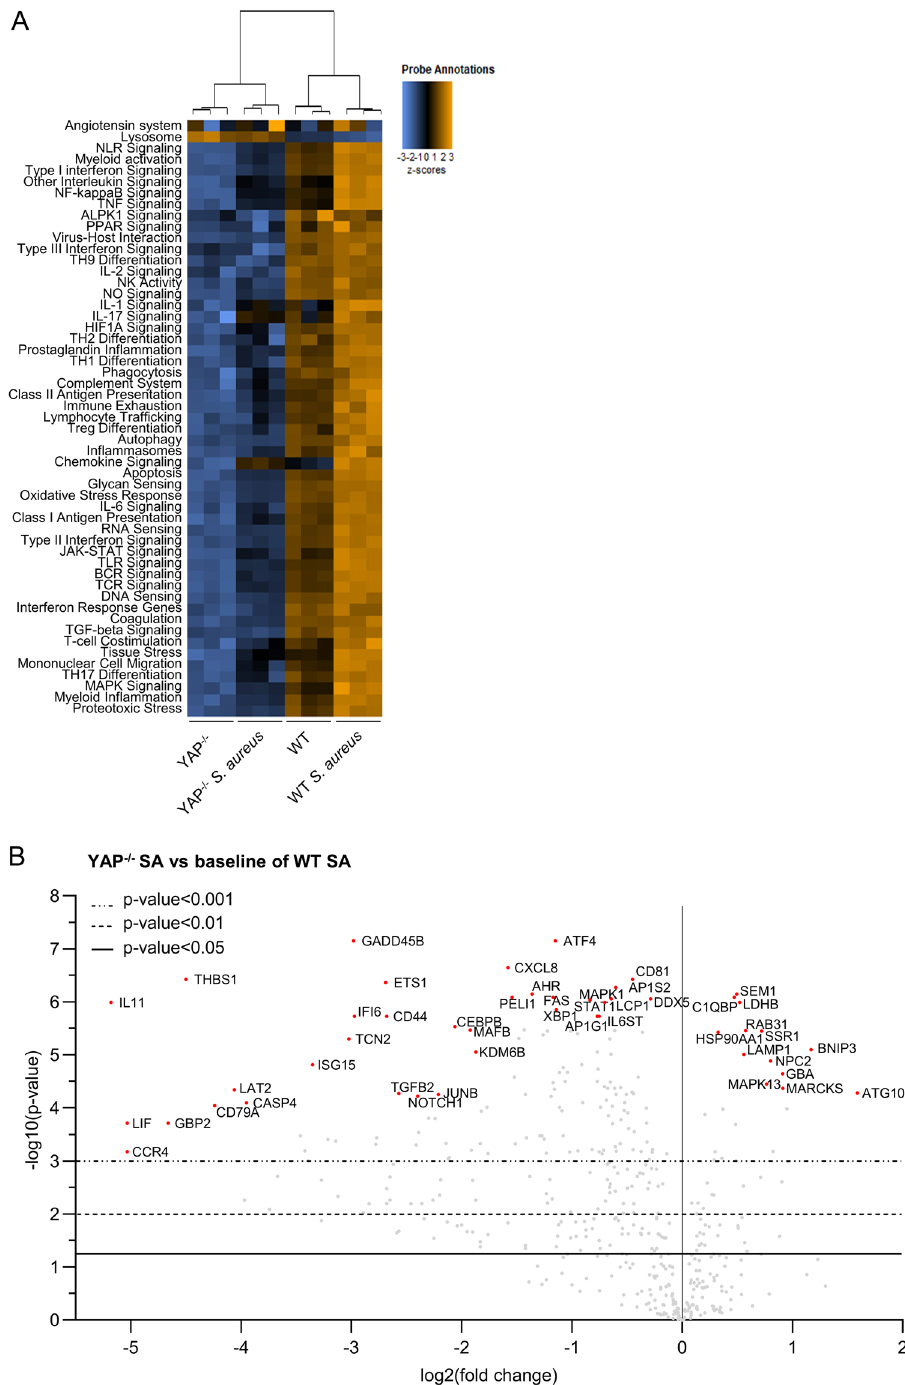
Fig. 3 | YAP promotes host response gene expression important during Sta- phylococcus aureus infection. HEK293 cellswerecultured atmedium density and infected with HG001 S. aureus strain at a multiplicity of infection of 10 for 7 h. Staphylococcus aureus were allowed to contact cells for 2h. Subsequently, lysos- taphin wasaddedat 10 µ g/mLfor theremaining experiments to avoid extracellular S. aureus multiplication. A Heat map of nCounter NanoString host response path- ways;pathwaysarelistedtotheleft,themostupregulatedpathwaysaredepictedin